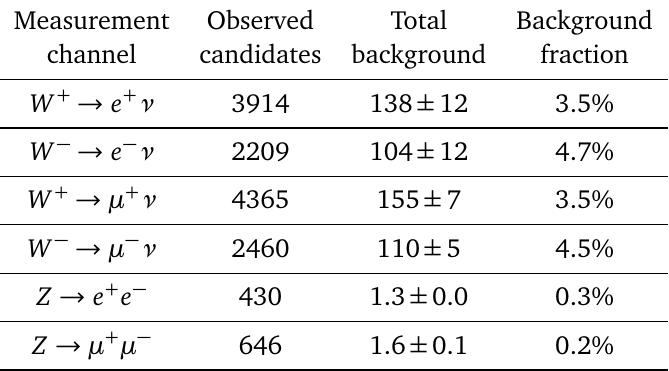
Table 1: Number of observed candidates and total background contributions for both the W and Z decay channels (Numbers are taken from [ 2 ] ). The background fractions in the Z channels are much lower than those in the W